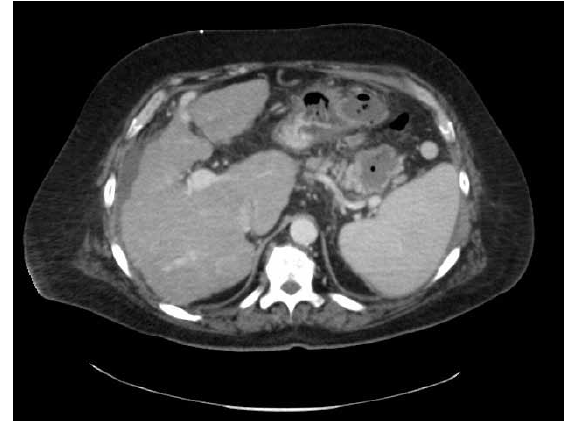
Figure 1. CT: walled off pancreatic necrosis Figure 2. CT: acute necrotic